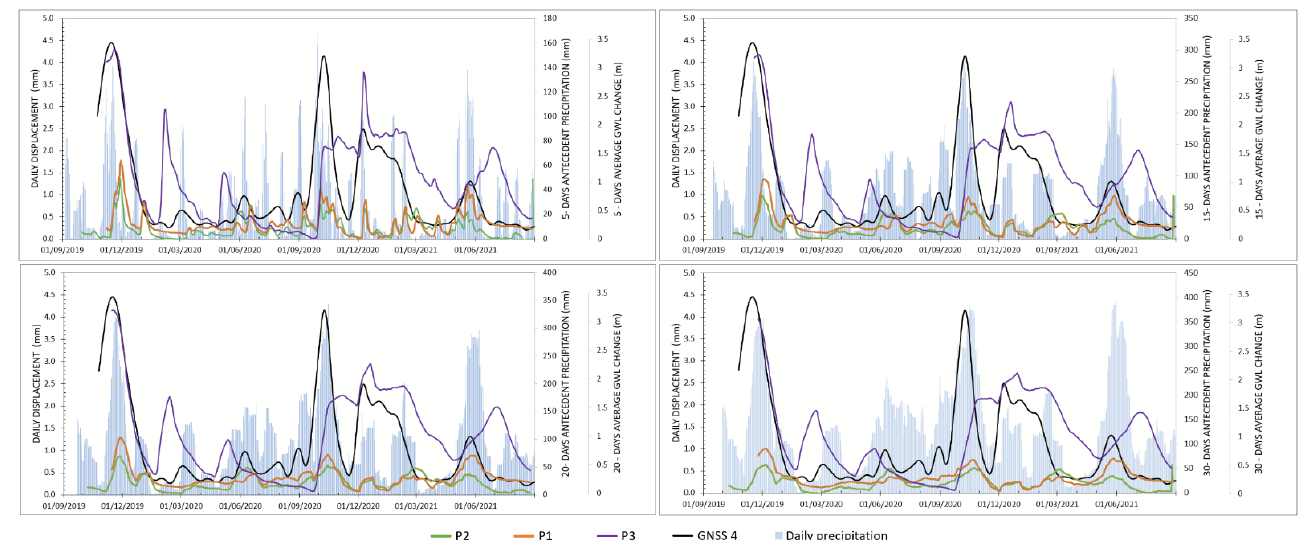
Figure 8. Time-series diagram showing the relationship among the daily displacements obtained by GNSS4 ; 5-, 15-, 20-, and 30-day antecedent precipitation; and 5-, 15-, 20-, and 30-days of average change in the groundwater table.